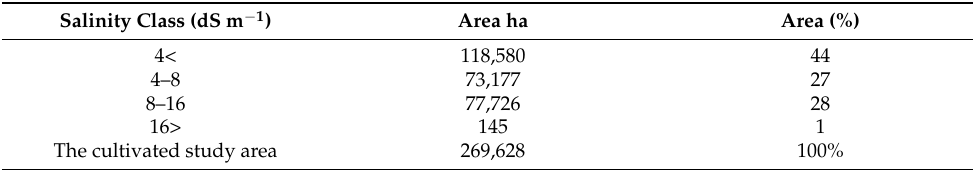
Table 4. The main salinity class categories in the study